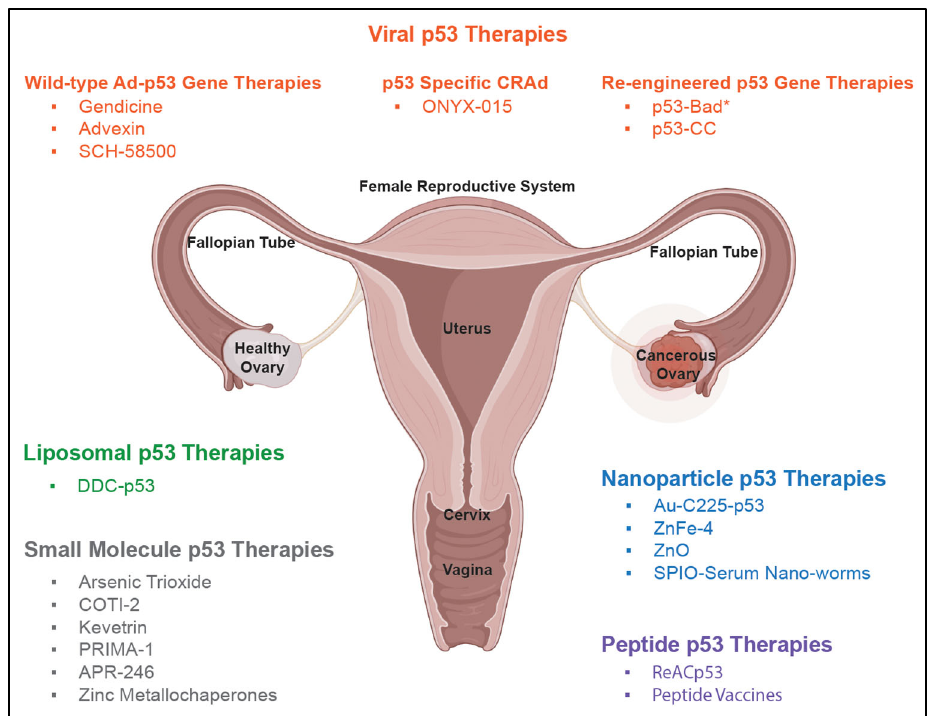
Figure 2. A selection of ovarian cancer p53-based therapies categorized into viral p53 therapies (wild- type Ad-p53 gene therapies, p53-specific CRAd, and re-engineered p53 gene therapies), nanoparticle p53 therapies, liposomal p53 therapies, peptide p53 therapies, and small molecule p53 therapies. Female reproductive system diagram from Bio Render.